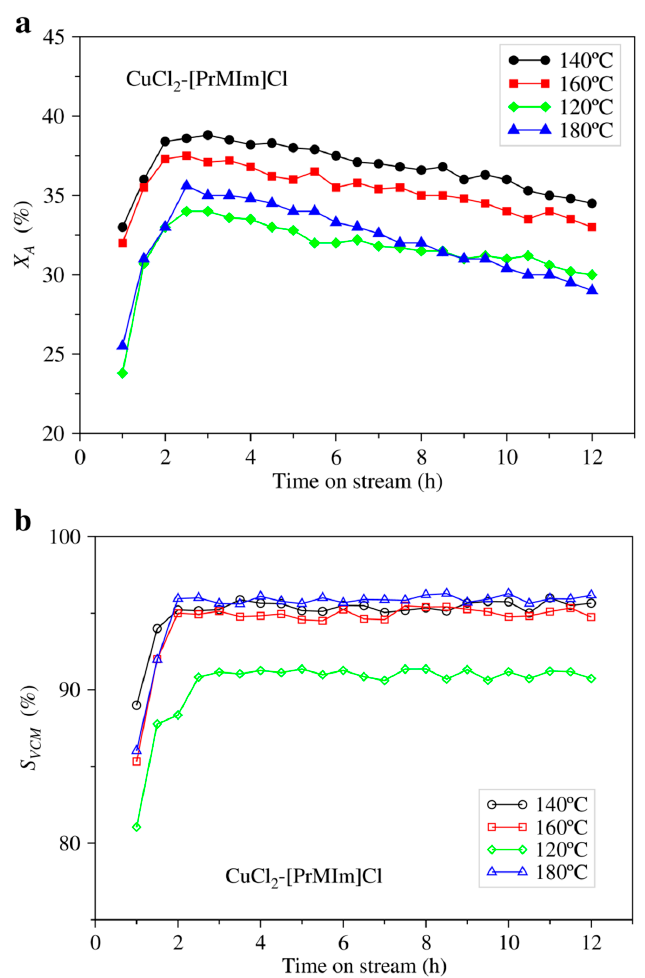
Figure 3. ( a ) C 2 H 2 conversion rate X A and ( b ) VCM selectivity S VCM of the catalyst CuCl 2 -[PrMIm]Cl as a function of reaction time at di ff erent temperatures. Reaction conditions: Concentration of CuCl 2 = 0.065 mol · L − 1 , C 2 H 2 GHSV = 370 h − 1 , feed volume ratio V HCl :V C2H2 =